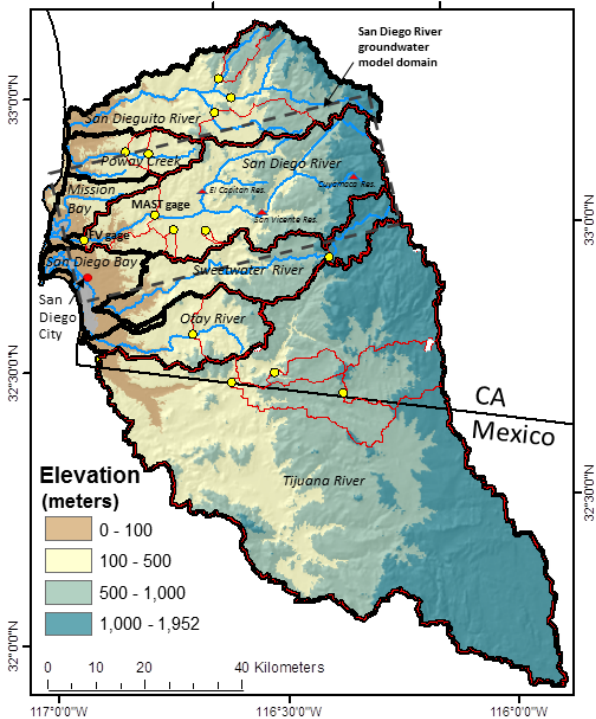
Fig. 1. Map of study area with major river basins outlined in black and calibration basins in red. Streamflow gages are noted as yellow points. San Diego River groundwater model domain, Mast Road (MAST) and Fashion Valley (FV) gages, and reservoirs in the San Diego River basin are